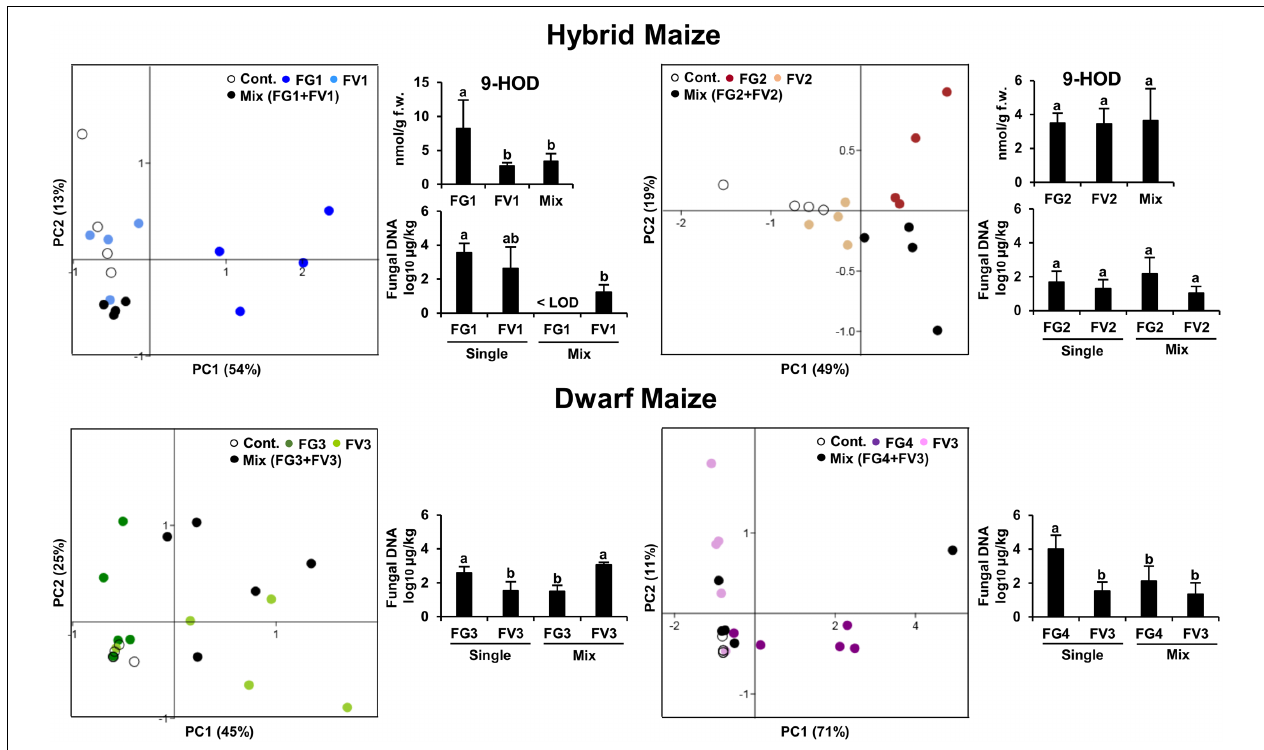
FIGURE 1 | Principle Component Analysis (PCA) of the volatile infection biomarkers in infected and uninfected maize ears for hybrid and dwarf maize. Each dot represents one replicate from each treatment. 9-HOD: (10 E ,12 Z )-9-hydroxy-10,12-octadecadienoic acid. FW, fresh weight. Different letters indicate statistical differences ( p < 0.05) Tukey’s pairwise